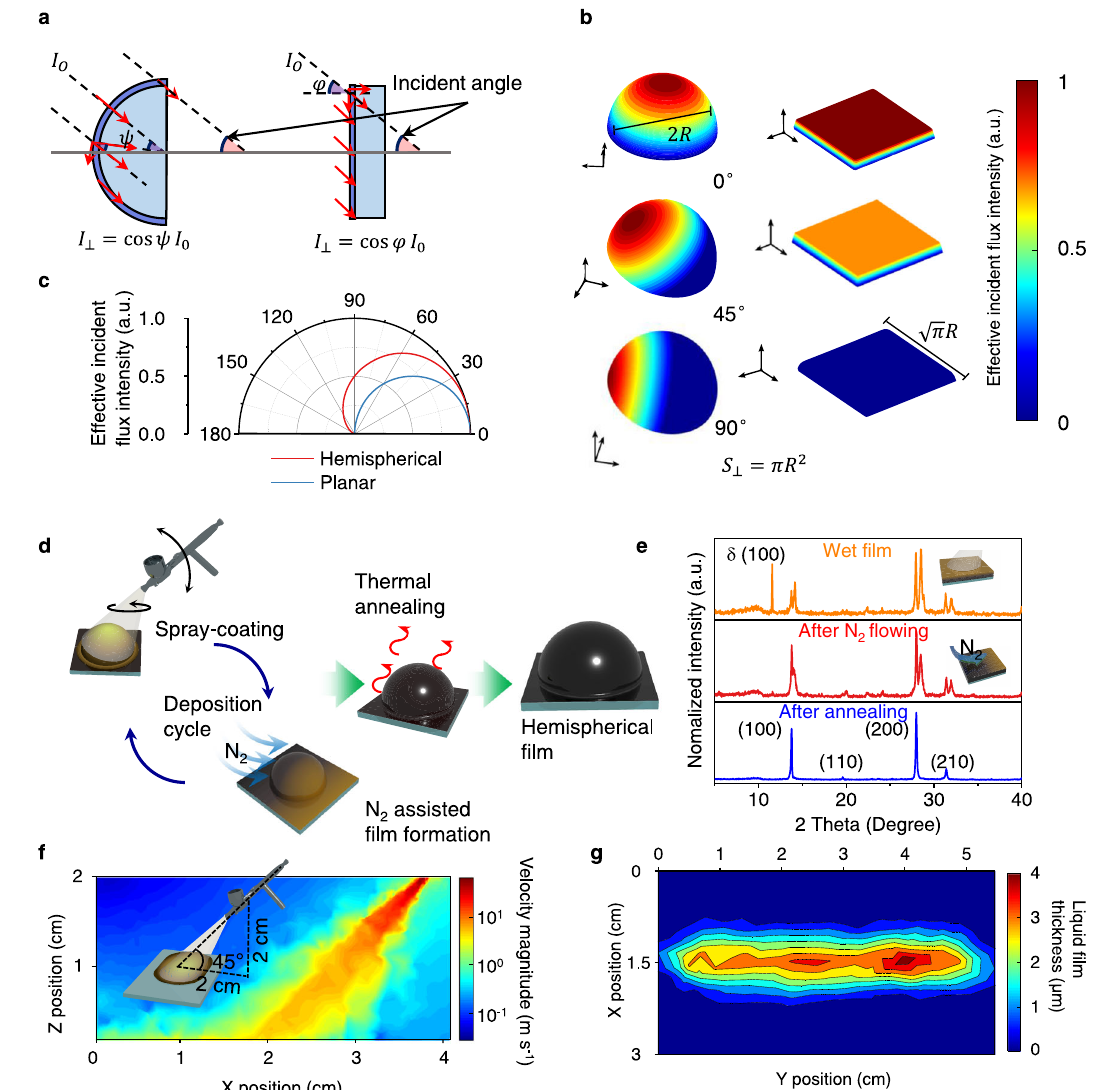
Fig. 1 | The effective incident fl ux intensity on hemispherical and planar sur- face, and thick perovskite fi lms by spray-coating. a Schematic diagram of the vertical component of incident light on hemispherical and planar surface. The incident light (red arrow) is decomposed into components parallel and perpendi- culartothesurface. ψ and φ areanglestoevaluatetheangleofincidentlight. b The simulated spatial distribution of effective incident fl ux incident of planar and hemispherical surface ( S ? = π R 2 ) under incident light from 0°, 45°, and 90°. c The